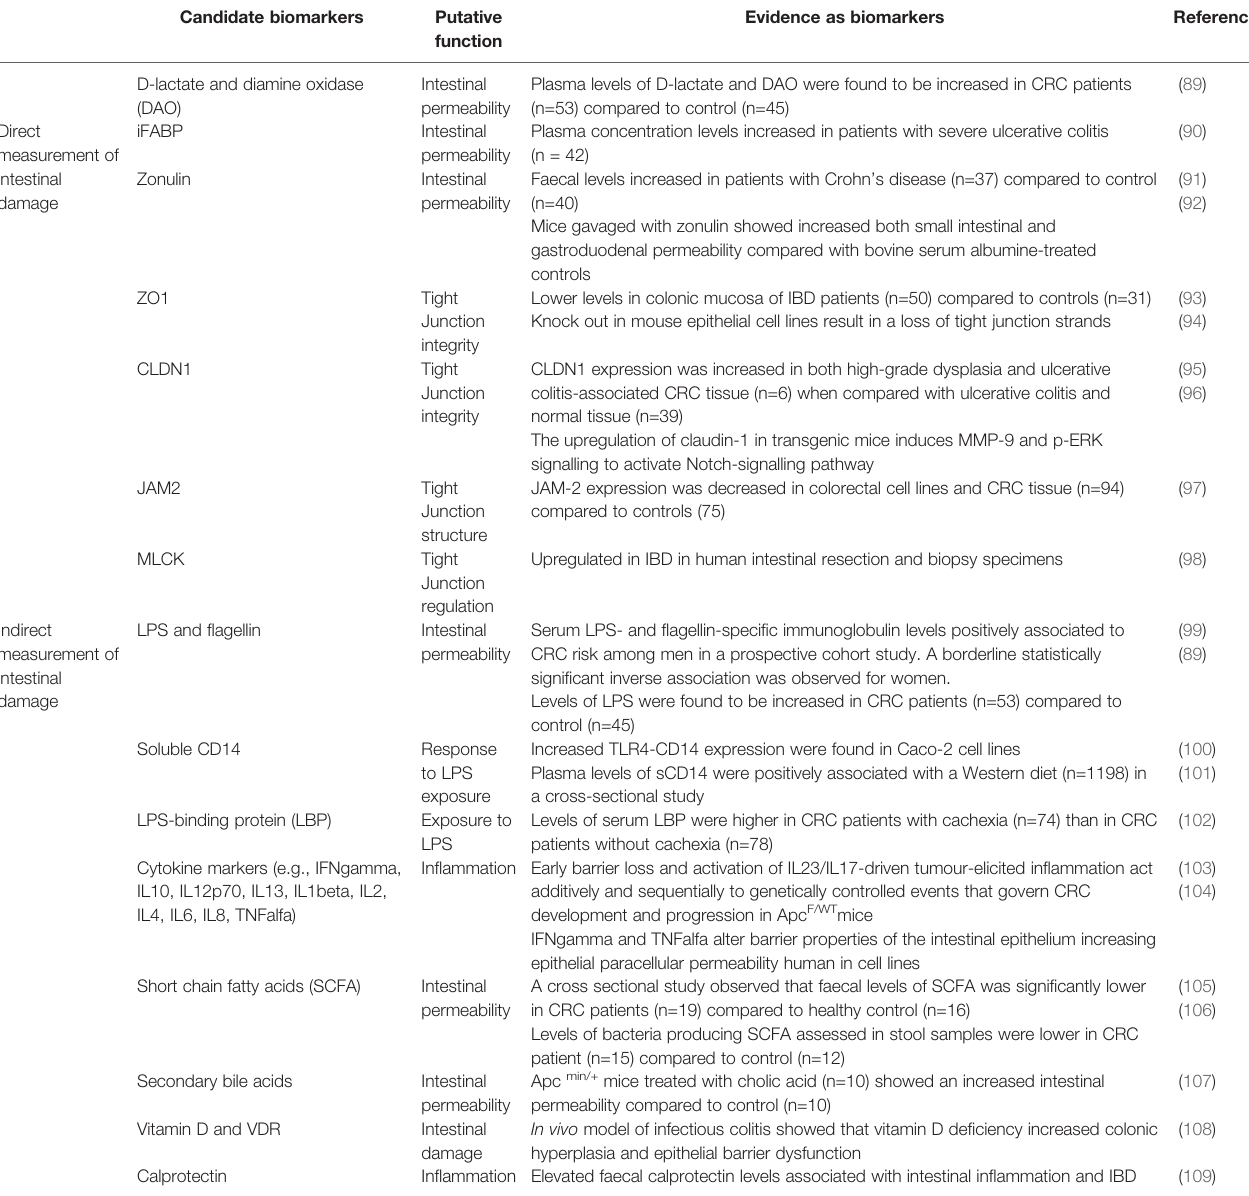
TABLE 1 | Candidate biomarkers for gut barrier damage in colorectal carcinogenesis. Candidate